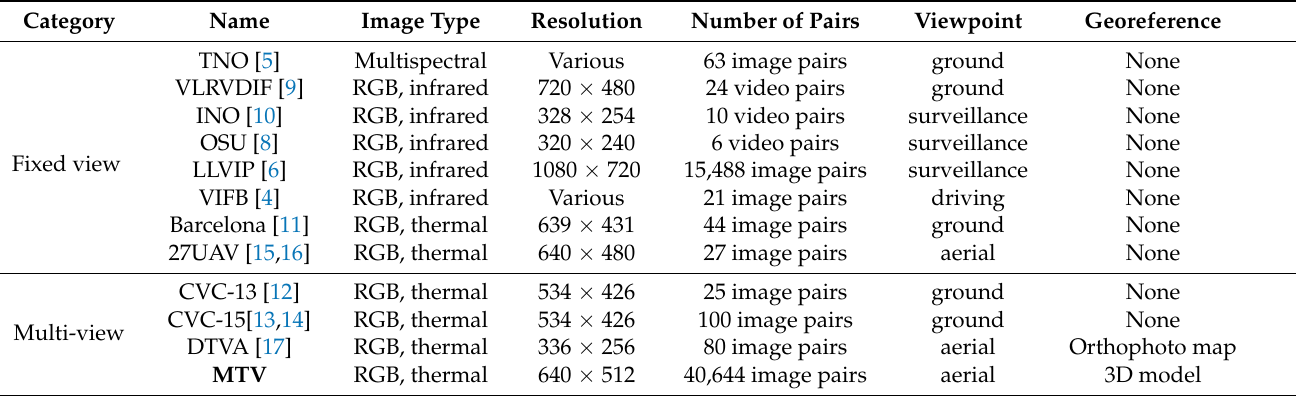
Table 1. Comparison of MTV and existing datasets.We have divided them into two categories based on whether there is a change in view: fixed-view and multi-view.